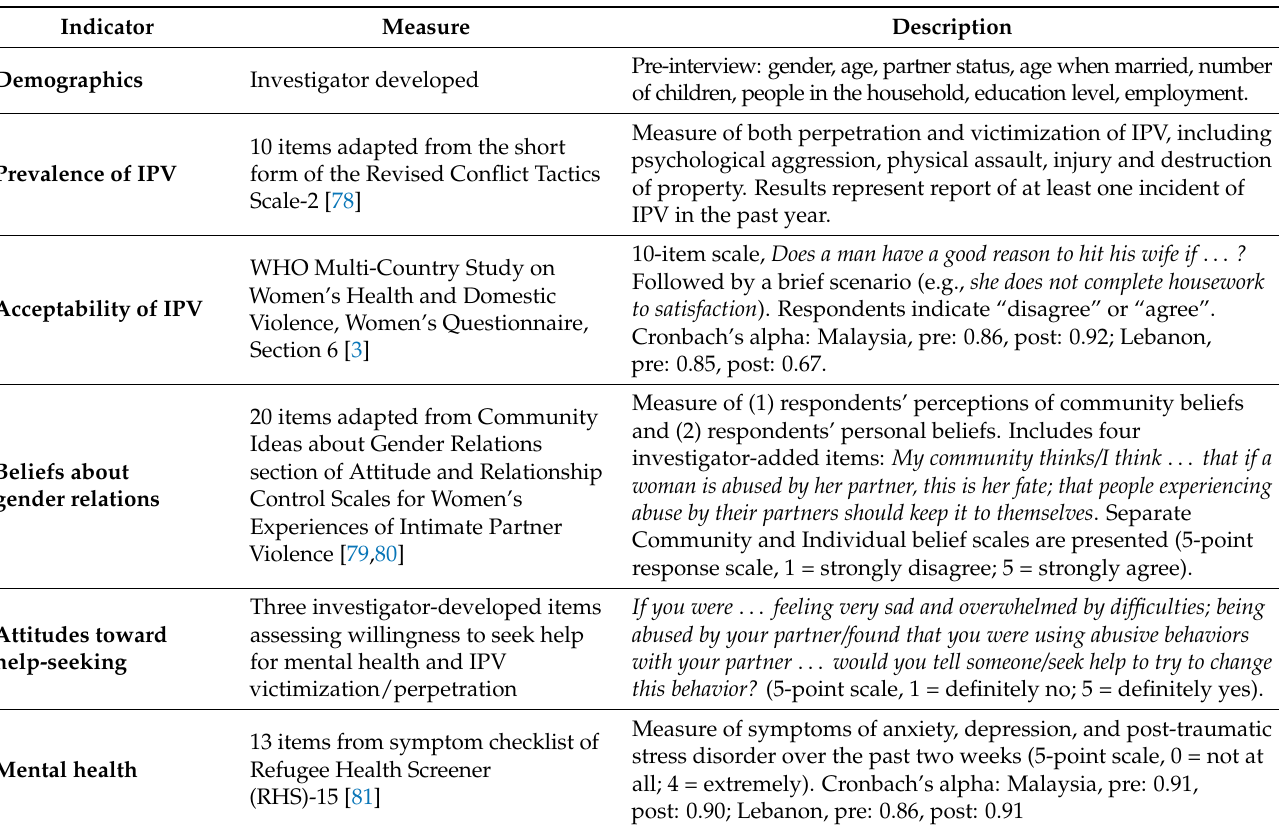
Table 1. Study 1 workshop interview